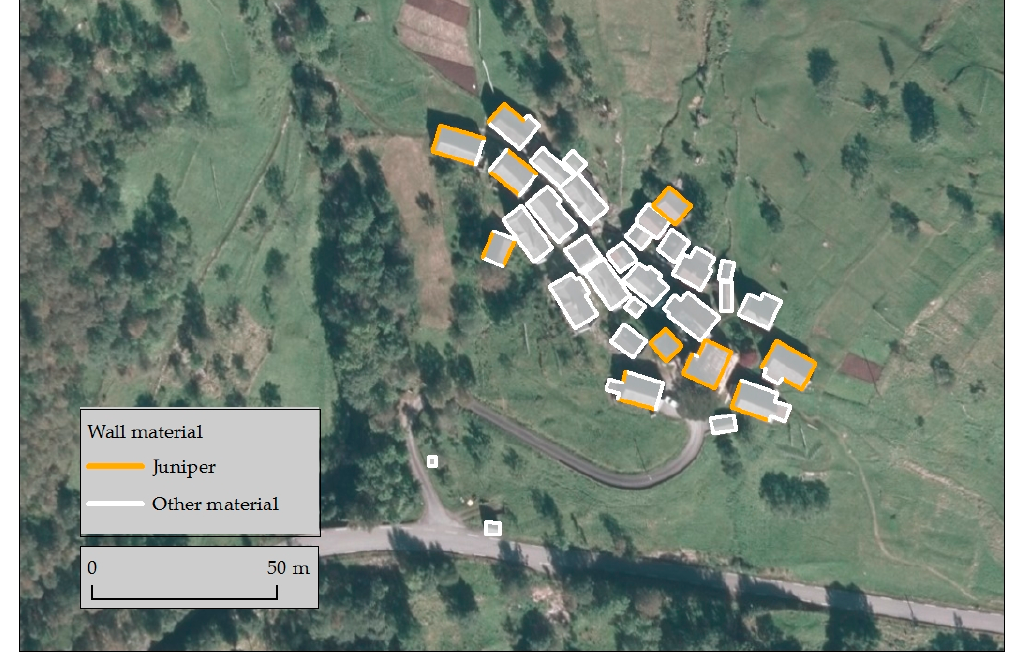
Figure 8. Use of intertwined juniper branches as wall cladding material was common in pre-industrial times, and still maintained on buildings in the Cultural Heritage Environment. See the example in Figure 6a. Aerial photo: https://norgeibilder.no.